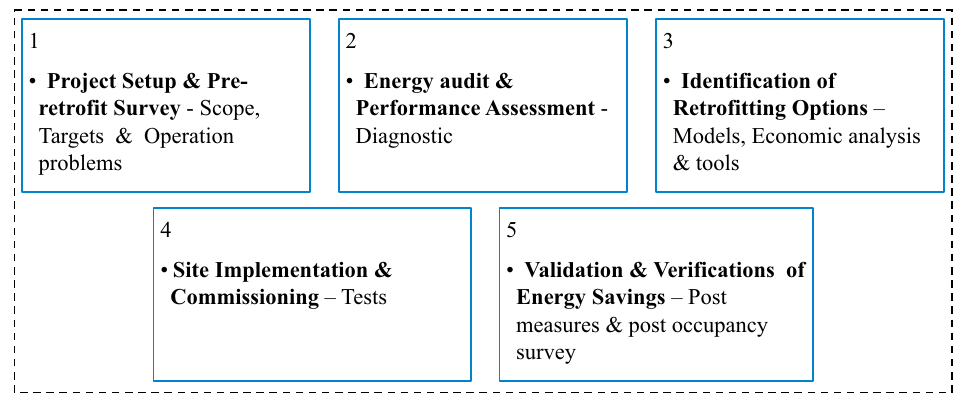
Fig. 2. Major phases used in a sustainable retro fi tting process of buildings.